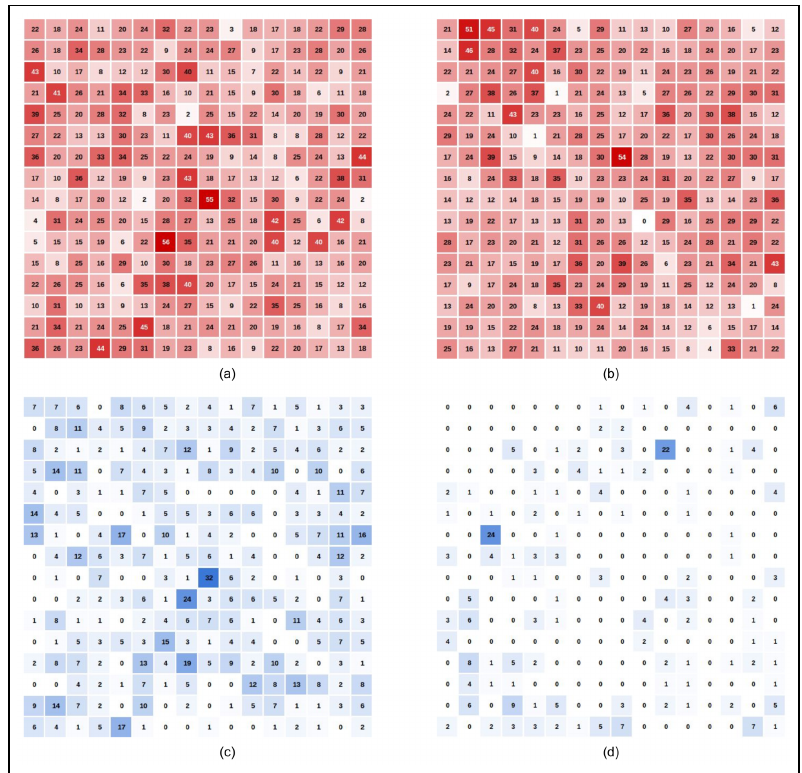
Figure 9. DVS/EMG hand gestures neurons BMU counters during multimodal learning and inference using Hebb − Sum All method: ( a ) DVS SOM in learning; ( b ) EMG SOM neurons during learning; Norm ( c ) DVS SOM neurons during inference; ( d ) EMG SOM neurons during